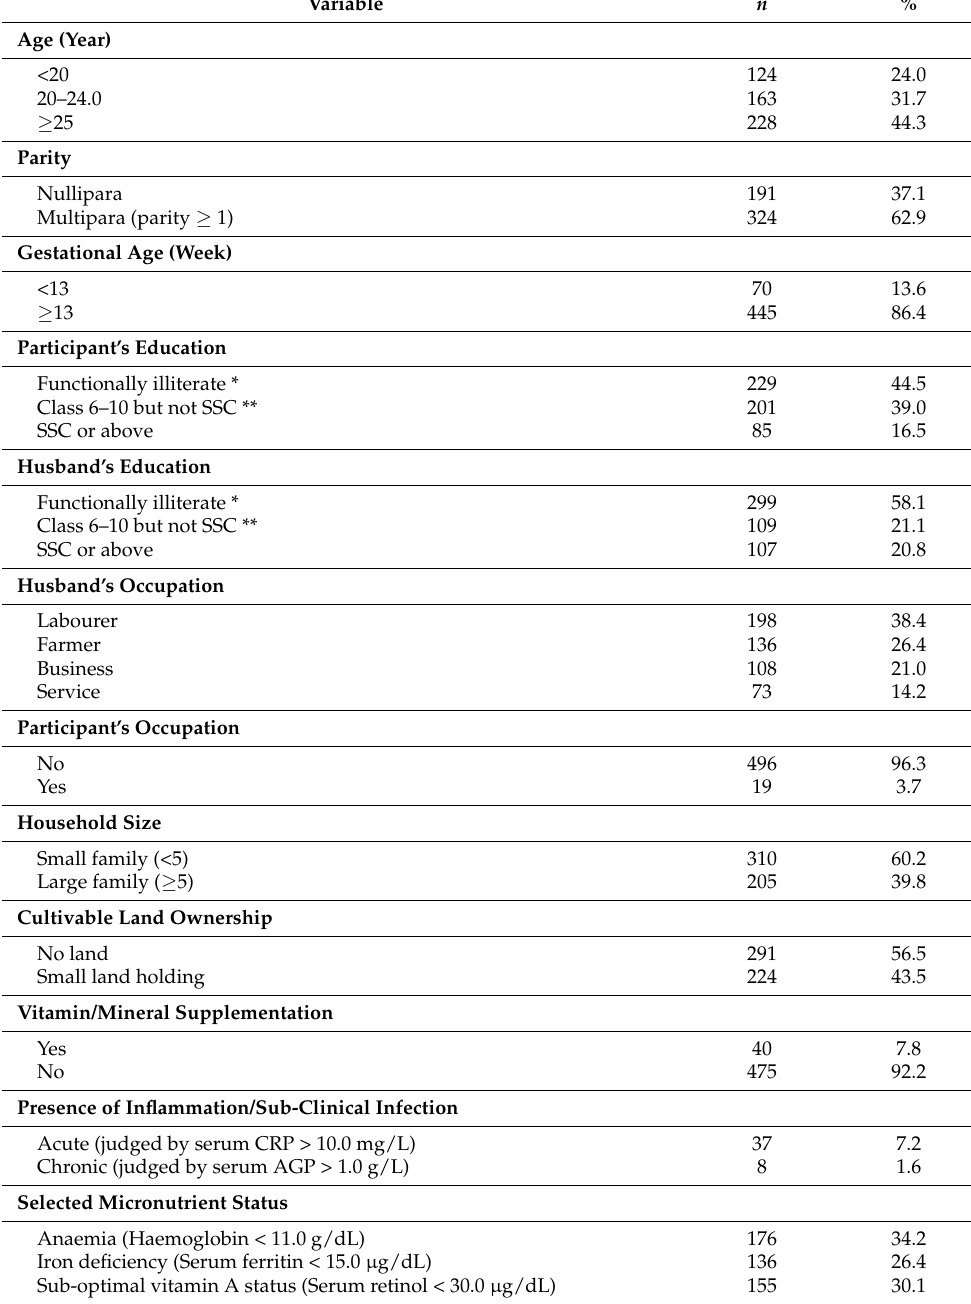
Table 1. Characteristics of the pregnant women who participated in the